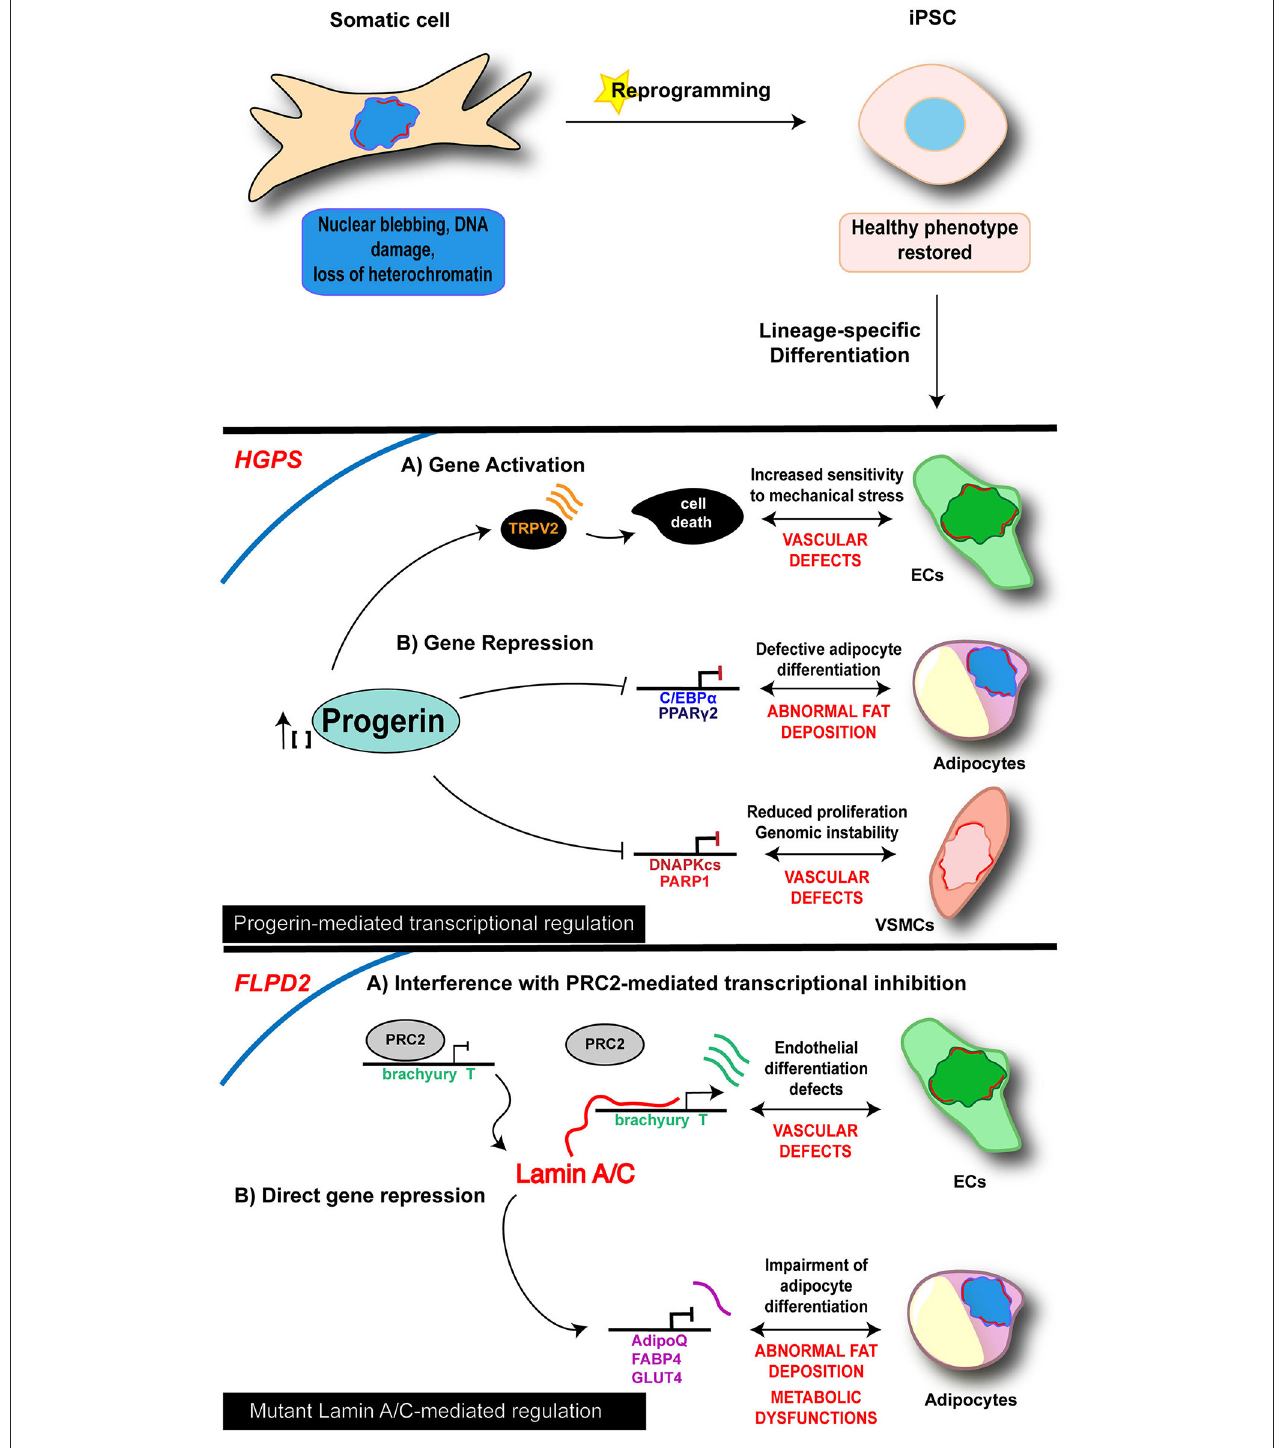
FIGURE 1 | Cell-specific mechanisms of iPSC-derived laminopathy models. Schematic representation of the main mechanisms investigated in iPSC-based models of laminopathies: the proposed pathogenetic mechanisms are presented relative to the specific and disease-relevant cell types. Representation is limited to the diseases and cell types in which an epigenetic involvement has been reported using iPSC technology. Lamin A/C is visualized as a red discontinuous segment in the inner part of the nucleus.